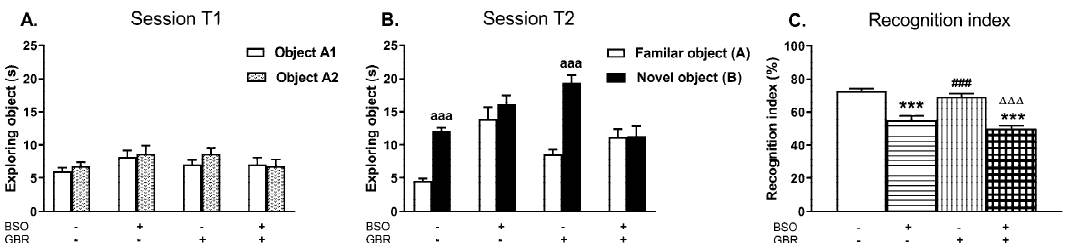
Figure 7. The effects of chronic administration of BSO and GBR 12909, alone or in combination, during the early postnatal life on cognitive functions assessed in adult 91-day-old rats in the novel object recognition test (NOR) test. ( A ) Effects of the examined model compounds on exploration of two identical objects in the acquisition trial (session T1). ( B ) Effects of the examined model compounds on exploration of a novel and a familiar object in the retention trial (session T2). ( C ) Effects of the examined model compounds on the recognition index. Data are presented as the mean ± SEM, n = 10 for each group. Letters indicate statistically significant differences between the exploration time of a familiar and a novel object in the session T2 within each studied group, according to the Student’s t -test for independent samples, aaa p < 0.001 vs. object A. Statistical analysis of recognition index was performed using a two-way ANOVA; symbols indicate significance of differences according to the Newman–Keuls post-hoc test, *** p < 0.001, vs. control; ### p < 0.001 vs. BSO-; and ∆∆∆ p < 0.001 vs. GBR 12909-treated groups.